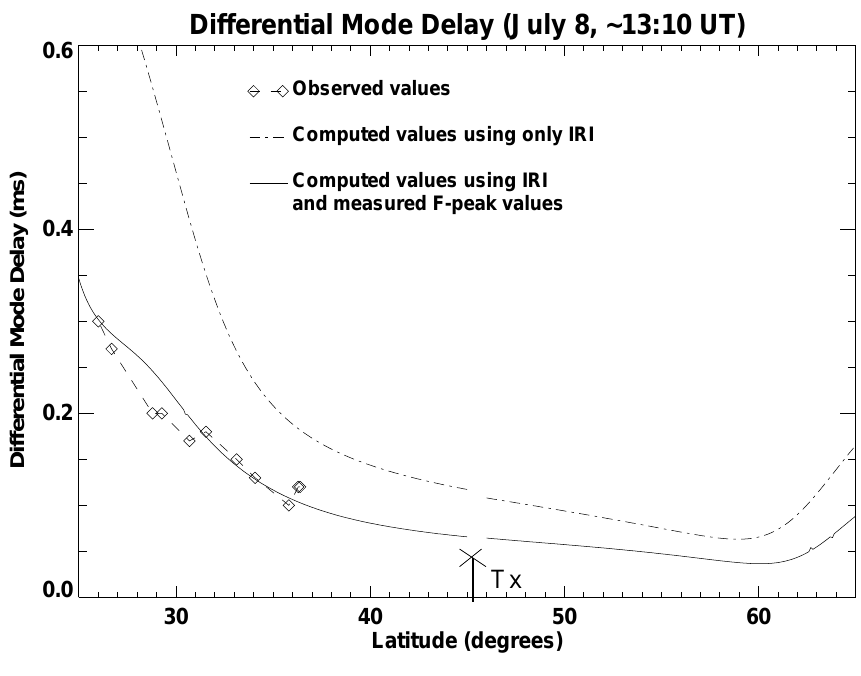
Fig. 3. An example comparison between simulated and observed differential mode delay times. This pass occurred on 8 July 1978, 13:10 UT. The two simulated curves represent two different electron density profiles, one generated using only the IRI model and the other using the model scaled to the topside sounding fo F2 values.